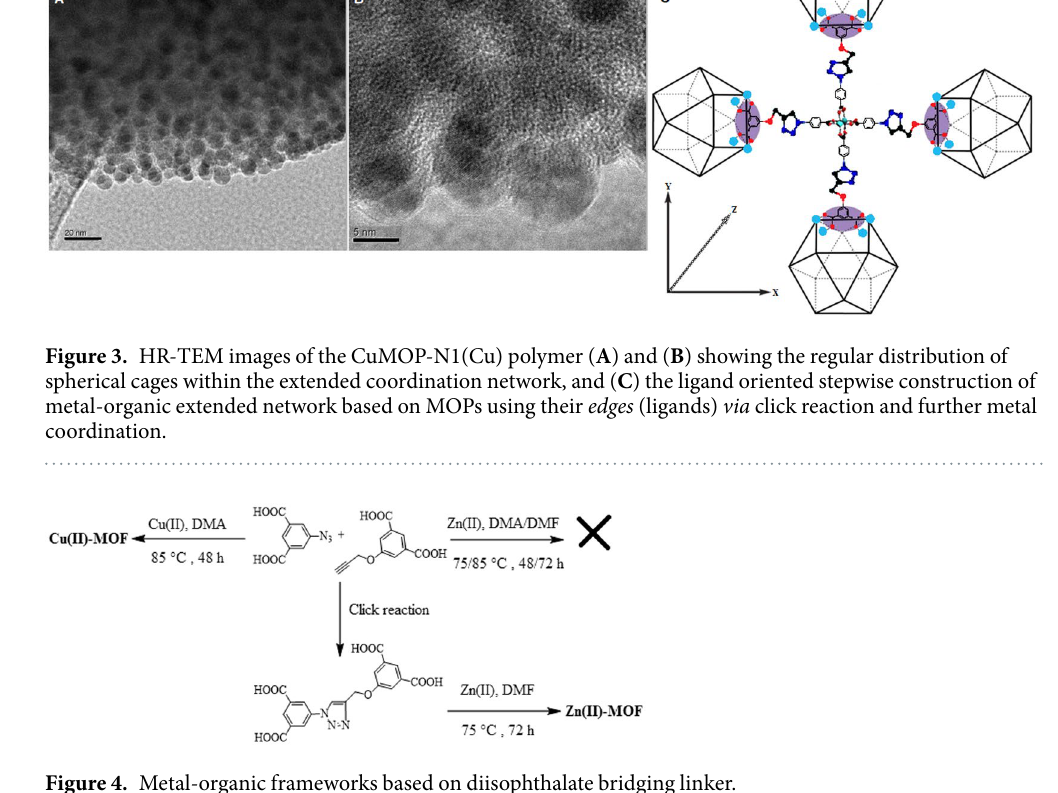
Figure 4. Metal-organic frameworks based on diisophthalate bridging